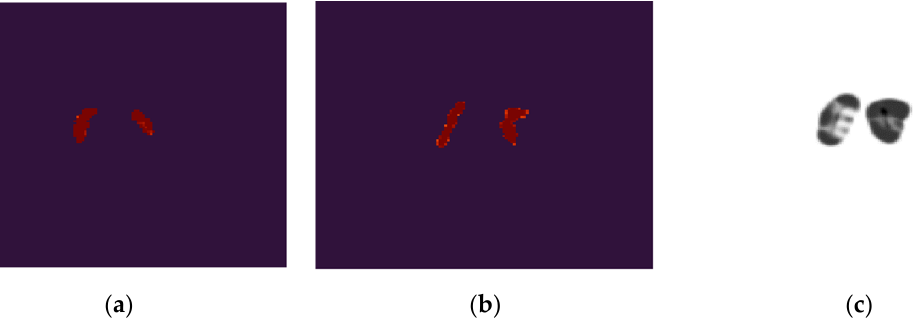
Figure 7. Study of the case of the smallest SSIM. ( a ) Shows the striatal region in a training phantom; ( b ) Shows the striatal region in a generated phantom; ( c ) Shows the local SSIM map when comparing ( a ) and ( b ). Note ( a , b ) were from different patients and could be in a different slice